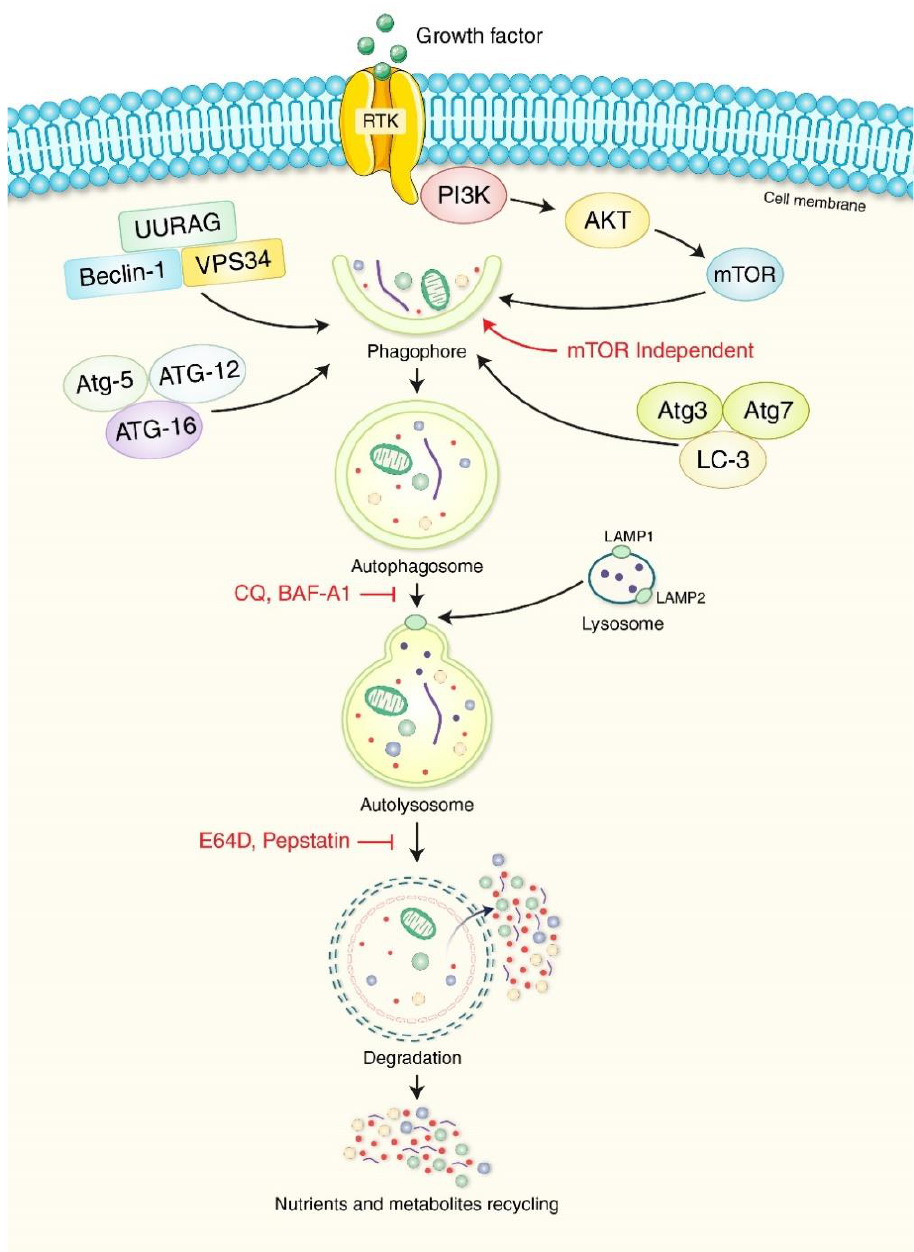
Figure 1. Molecular mechanism of autophagy. The autophagy process begins through the formation of phagophore structures. PI3K, protein kinase B (AKT), and mTOR are important for phagophore initiation. The BECN1, UVRAG, and VPS34 complex facilitate phagophore formation. Phagophore lysosomes leads to autolysosome formation. Chloroquine (CQ), Bafilomycin A1 (BAF-A1),